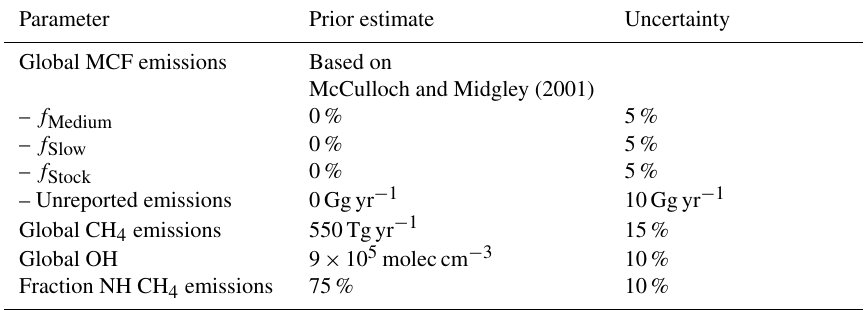
Table 1. The relevant settings we used in the inversion of our two-box model. The upper section contains the parameters optimized in the inversion, which were also perturbed in the Monte Carlo ensemble. These parameters have Gaussian uncertainties, and their mean and 1 σ uncertainty are given. The middle section contains parameters that were perturbed in the Monte Carlo, but not optimized. The middle parameters have uniform uncertainties, of which the lower and upper bound are given. The bottom section contains parameters that were neither optimized nor perturbed. For these parameters, the left column gives the standard setting, whereas the alternative column indicates whether we also ran an inversion using a TM5-derived time series (see Sect.